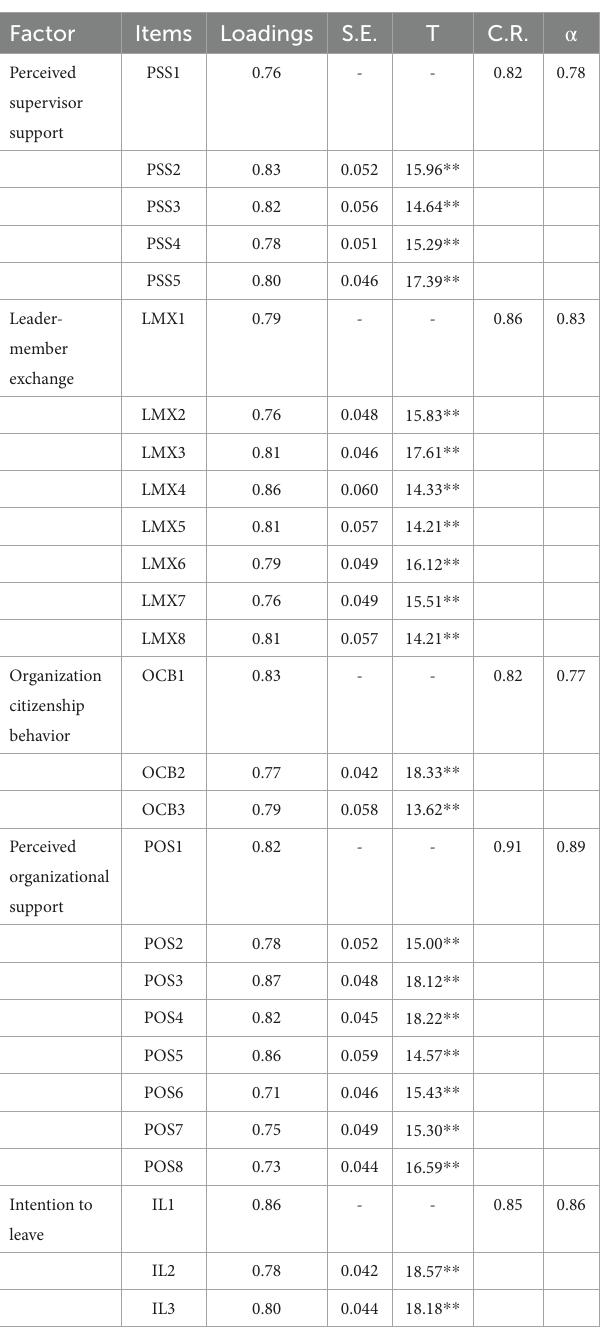
TABLE 4 Measurement model. TABLE 5 Direct and indirect β